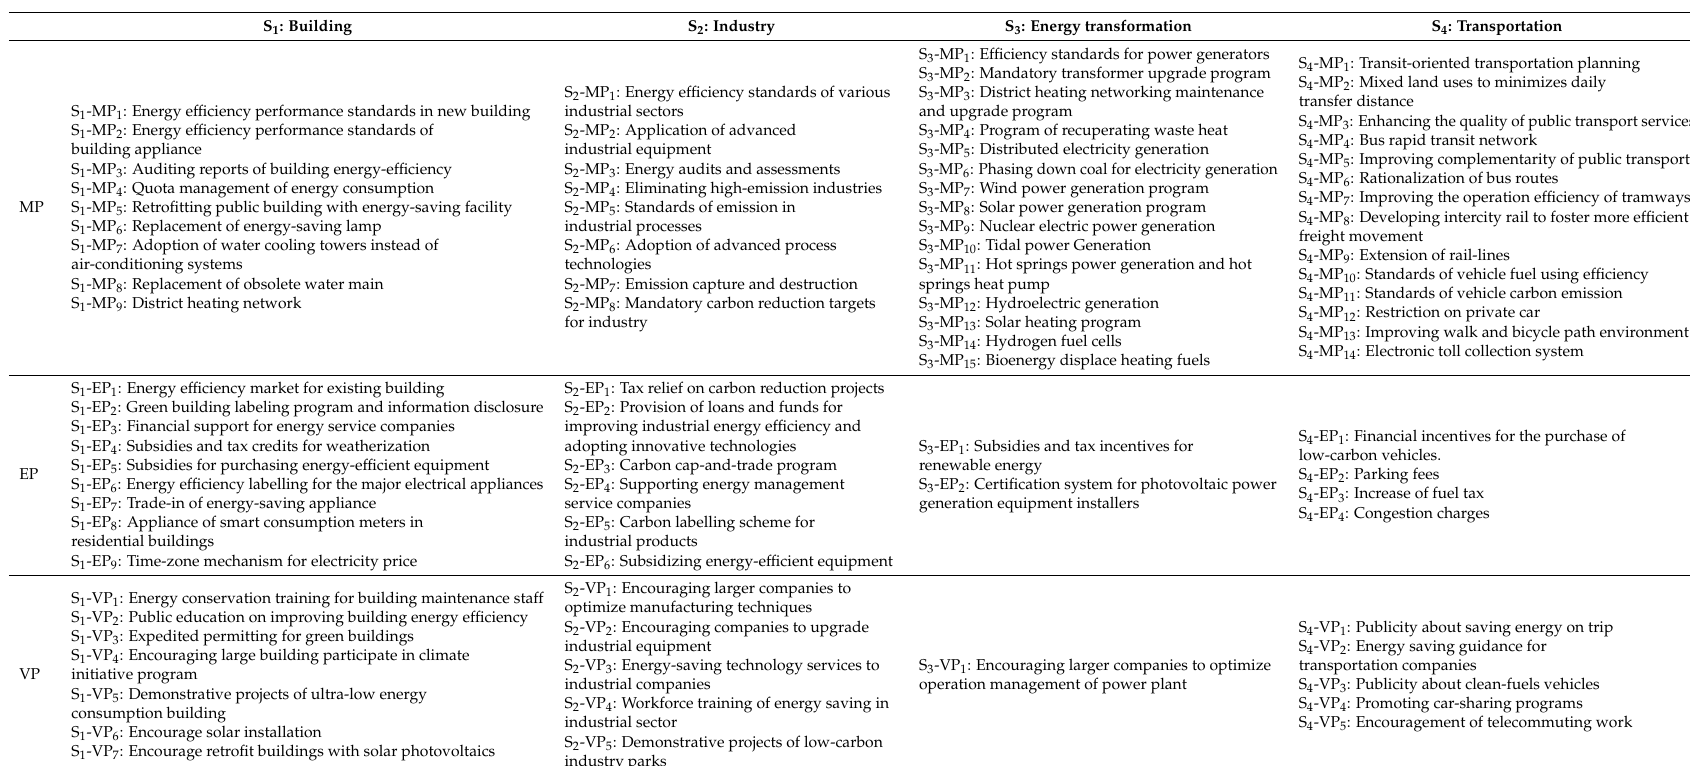
Table 10. Typical carbon reduction policies in different emission